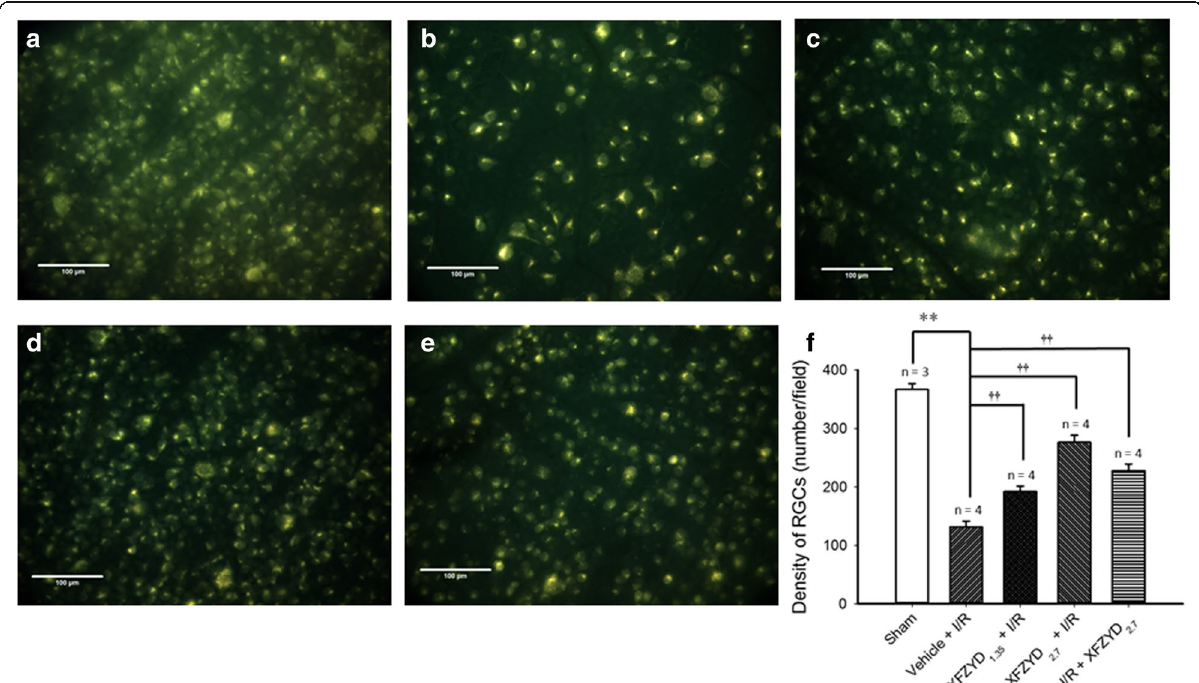
Fig. 2 Retrograde staining with fluorogold. The micrographs revealed the density of retinal ganglion cells (RGCs) after the sham process ( a , Sham), ischemia plus reperfusion (I/R) with preadministered vehicle ( b , Vehicle + I/R), preadministered XFZYD at 1.35 g/kg/day ( c , XFZYD 1.35 + I/R), preadministered XFZYD at 2.7 g/kg/day ( d , XFZYD 2.7 + I/R), or postadministered XFZYD at 2.7 g/kg/day (e, I/R + XFZYD 2.7 ). Quantitative analysis of the density of RGCs is shown ( f ). The mean values ± SD ( n = 3 ~ 4) was shown for each bar. ** represents a significant difference ( p < 0.01; Sham vs. Vehicle + I/R); †† represents a significant difference ( p < 0.01; Vehicle + I/R vs. XFZYD 1.35 + I/R, XFZYD 2.7 + I/R or I/R + XFZYD 2.7 ). XFZYD, Xue-Fu- Zhu-Yu decoction. Scale bars = 100 μ